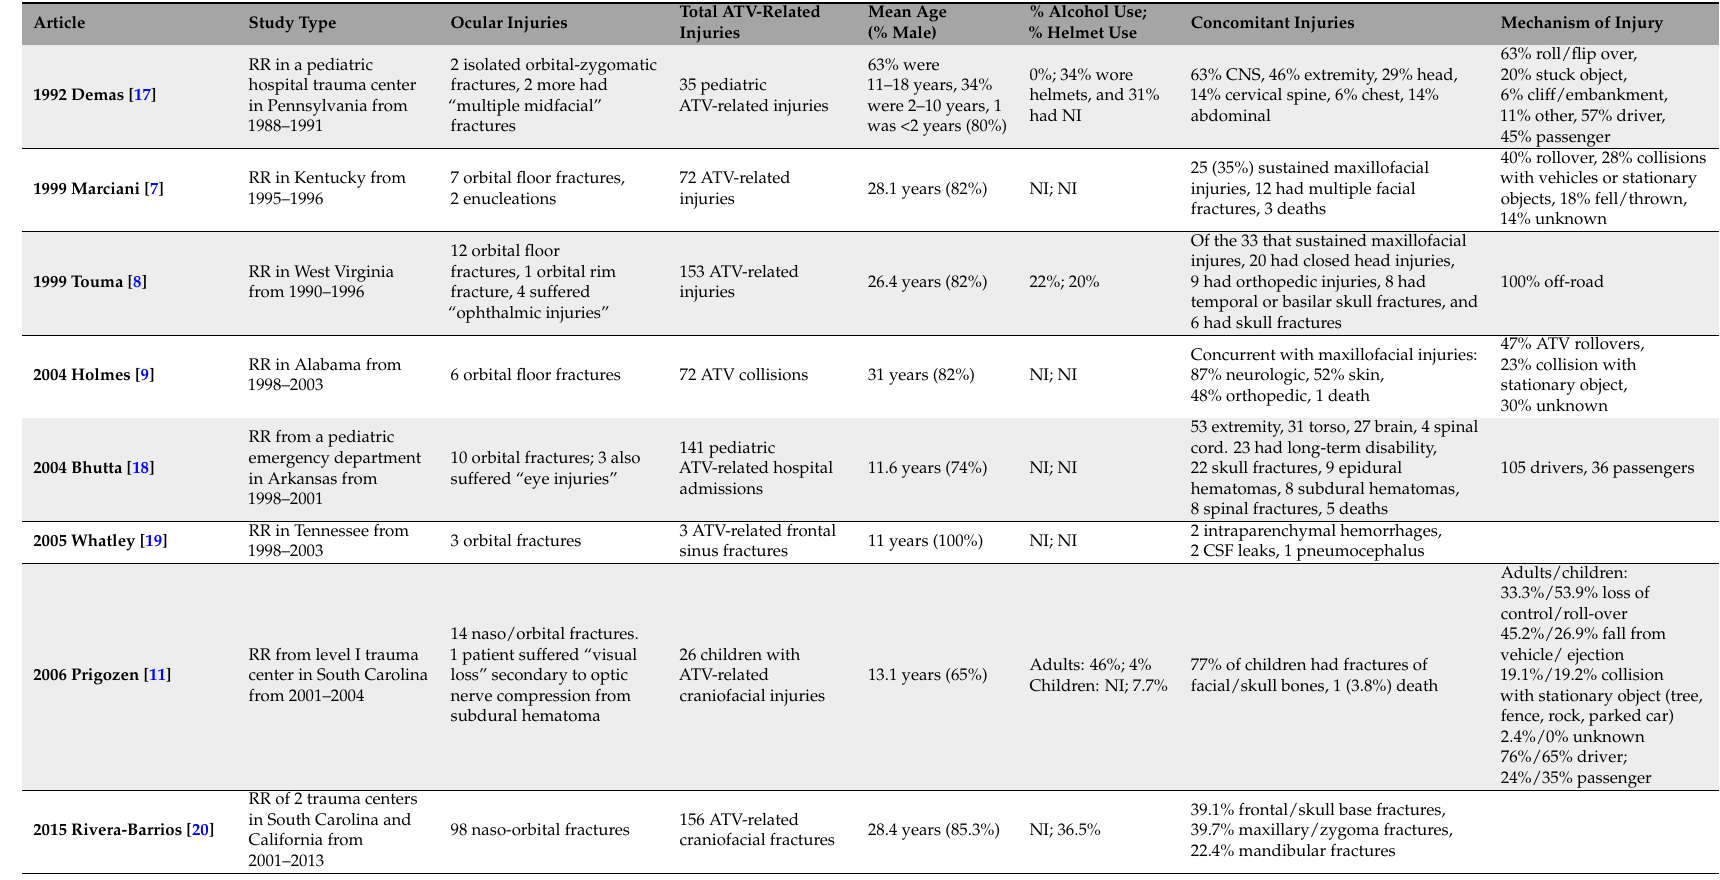
Table 2. ATV-related orbital fractures. Drug use and use of ocular protection was not recorded for any study. ATV: all-terrain vehicle. RR: retrospective review. NI: no information. CSF: cerebrospinal fluid. CNS, central nervous